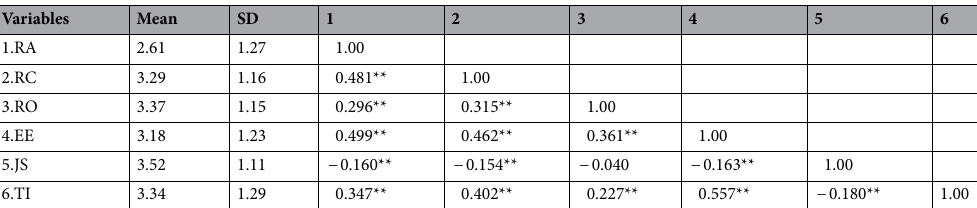
Table 3. Results of descriptive statistics and correlations. Source: Made by the authors. RA Role ambiguity, RC Role conflict, RO Role overload, EE Emotional exhaustion, JS Job satisfaction, TI Turnover intention, SD Standard deviation.